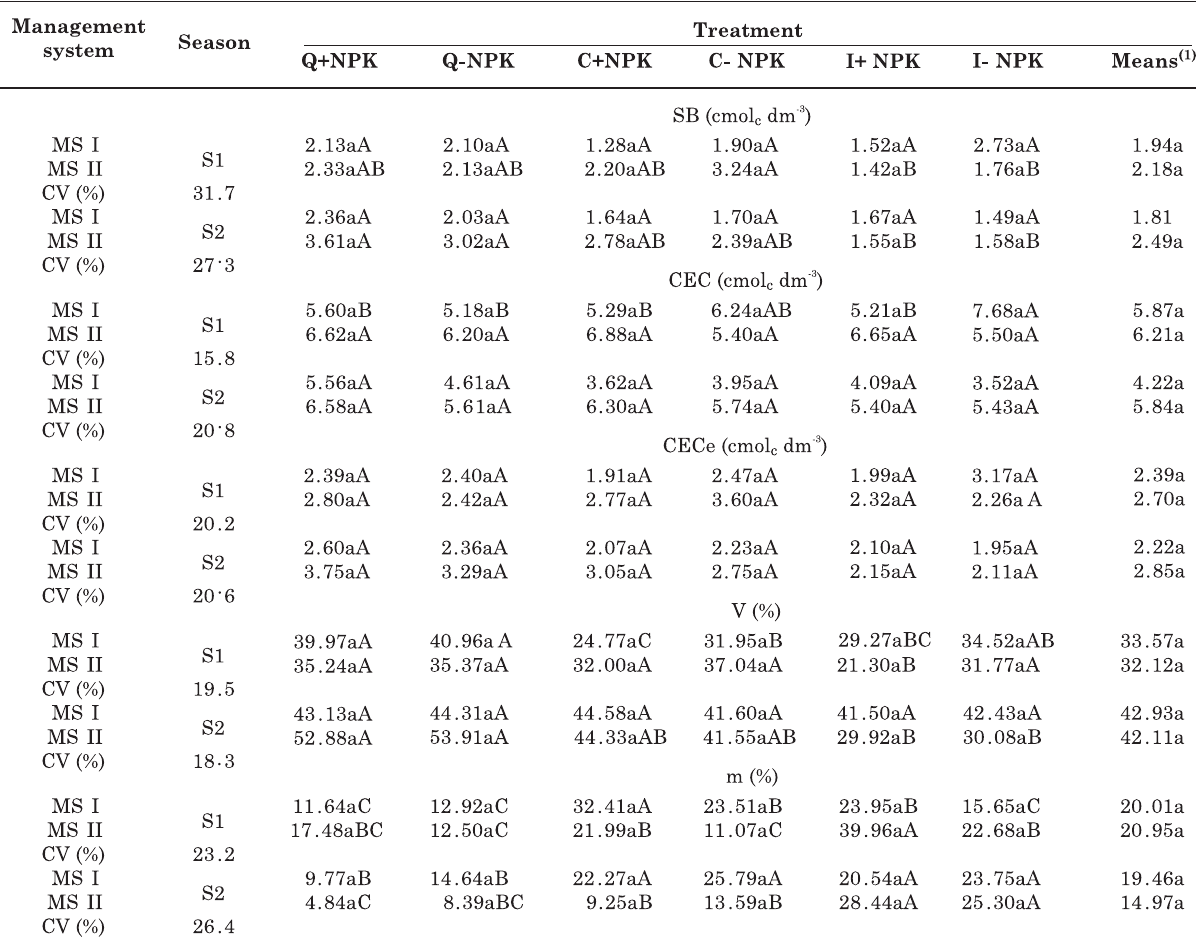
Table 4. Sum of bases (SB), effective cation exchange capacity (CECe), total cation exchange capacity